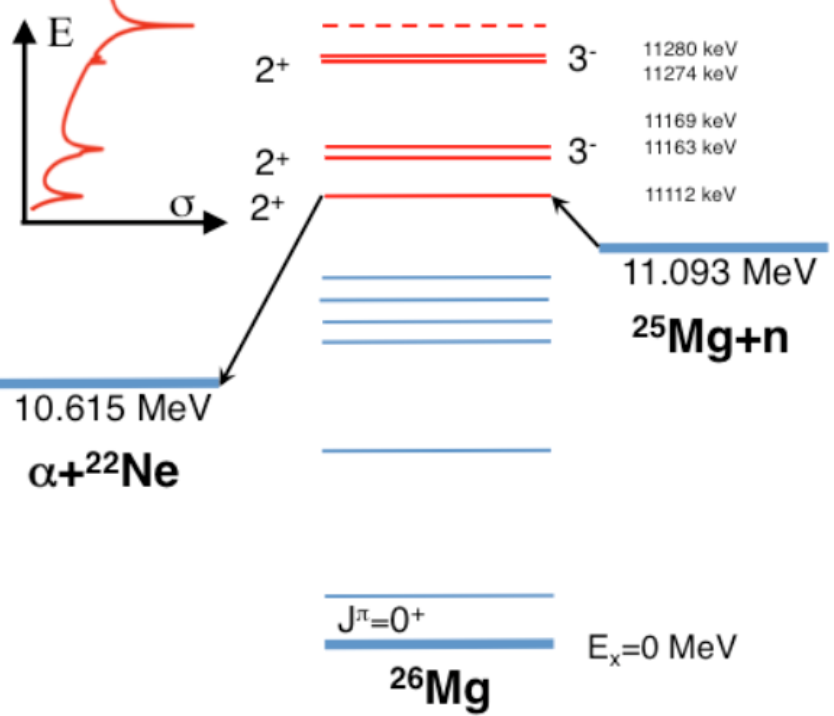
Figure 4. Level scheme of 26 Mg with the 25 Mg(n, γ ) entrance channel and the 22 Ne( α ,n) exit channel. The 26 Mg levels characterised in terms of excitation energy and J π by the collaborative effort of n_TOF and GELINA are reported in